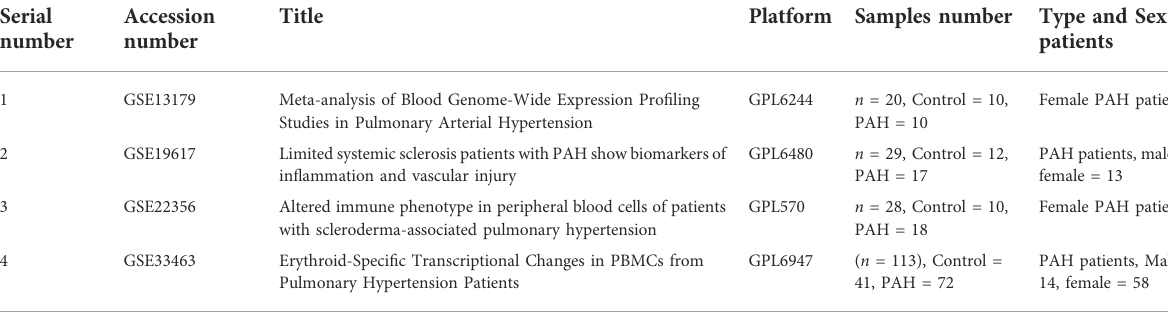
TABLE 1 The datasets information and patients ’ characteristics included in our